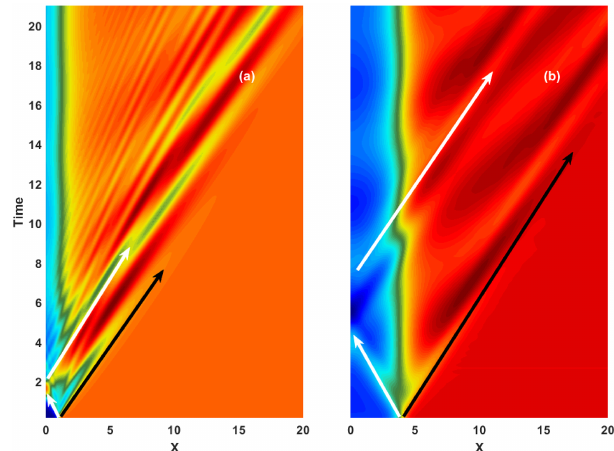
Figure 9. Space–time pseudocolour plots of the change in poten- tial energy for the Ro = 1, f = f 0 , and w = 0 . 5 w 0 case (a) , and the Ro = 0 . 25, f = f 0 , and w = 2 w 0 case (b) . As for the kinetic en- ergy, it has been scaled to the maximum value. Visible in both cases (though significantly easier to see in panel b ), there are both right- ward (black arrow) and leftward (white arrow) propagating wave trains created by the initial conditions. The leftward travelling wave train will eventually reflect off the close left-hand wall and propa- gate rightwards. If the initial conditions are quite narrow, the left- ward propagating wave train reflects quickly off the wall and is dif- ficult to disentangle from the rightward propagating wave train.